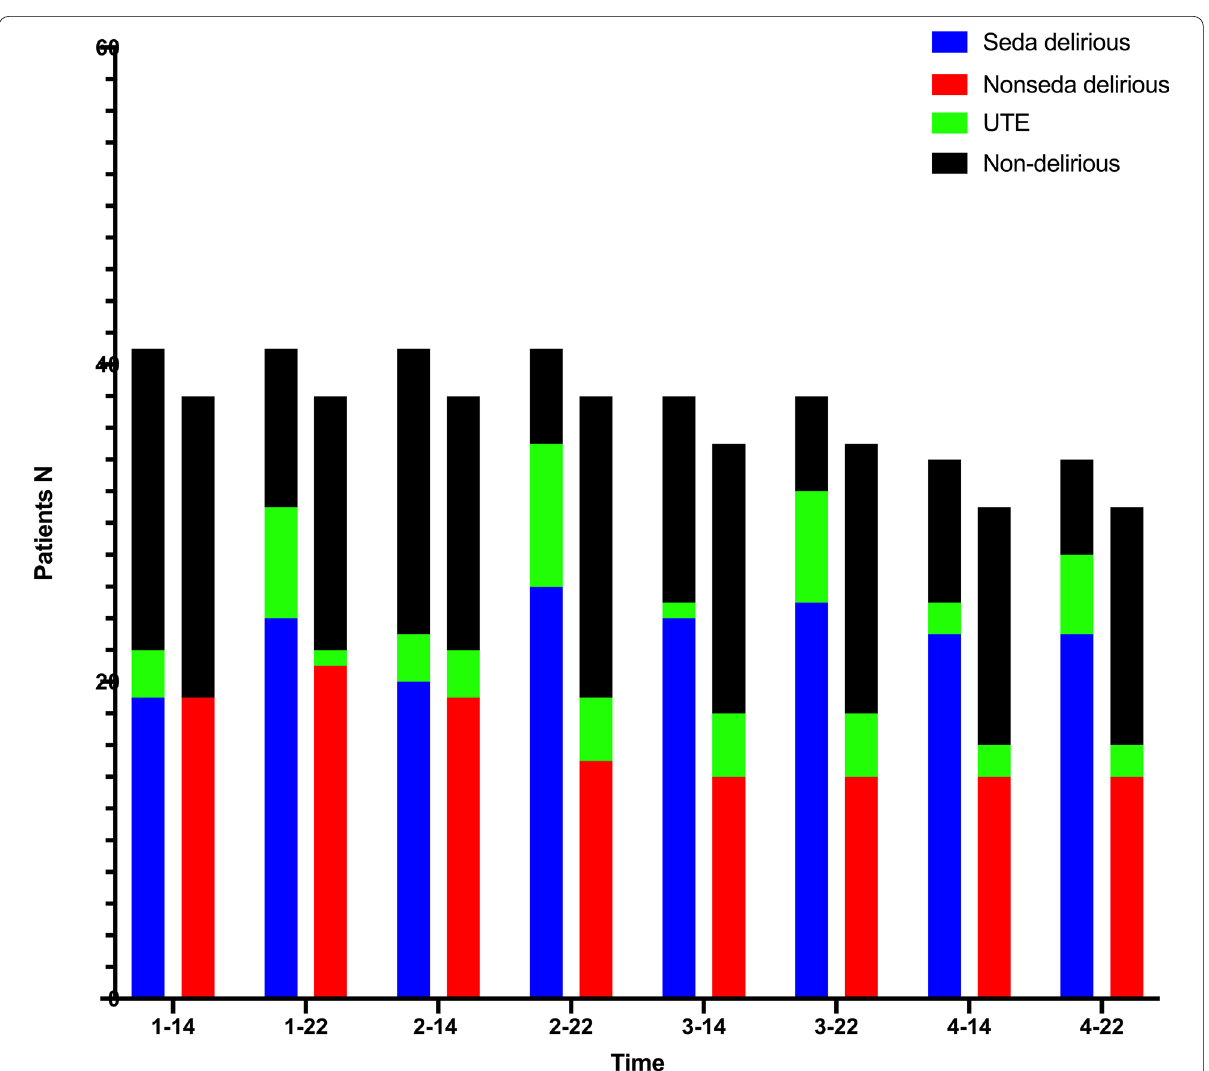
Fig. 4 Patients N with positive and negative CAM-ICU test evaluated twice per day. UTE; Unable To